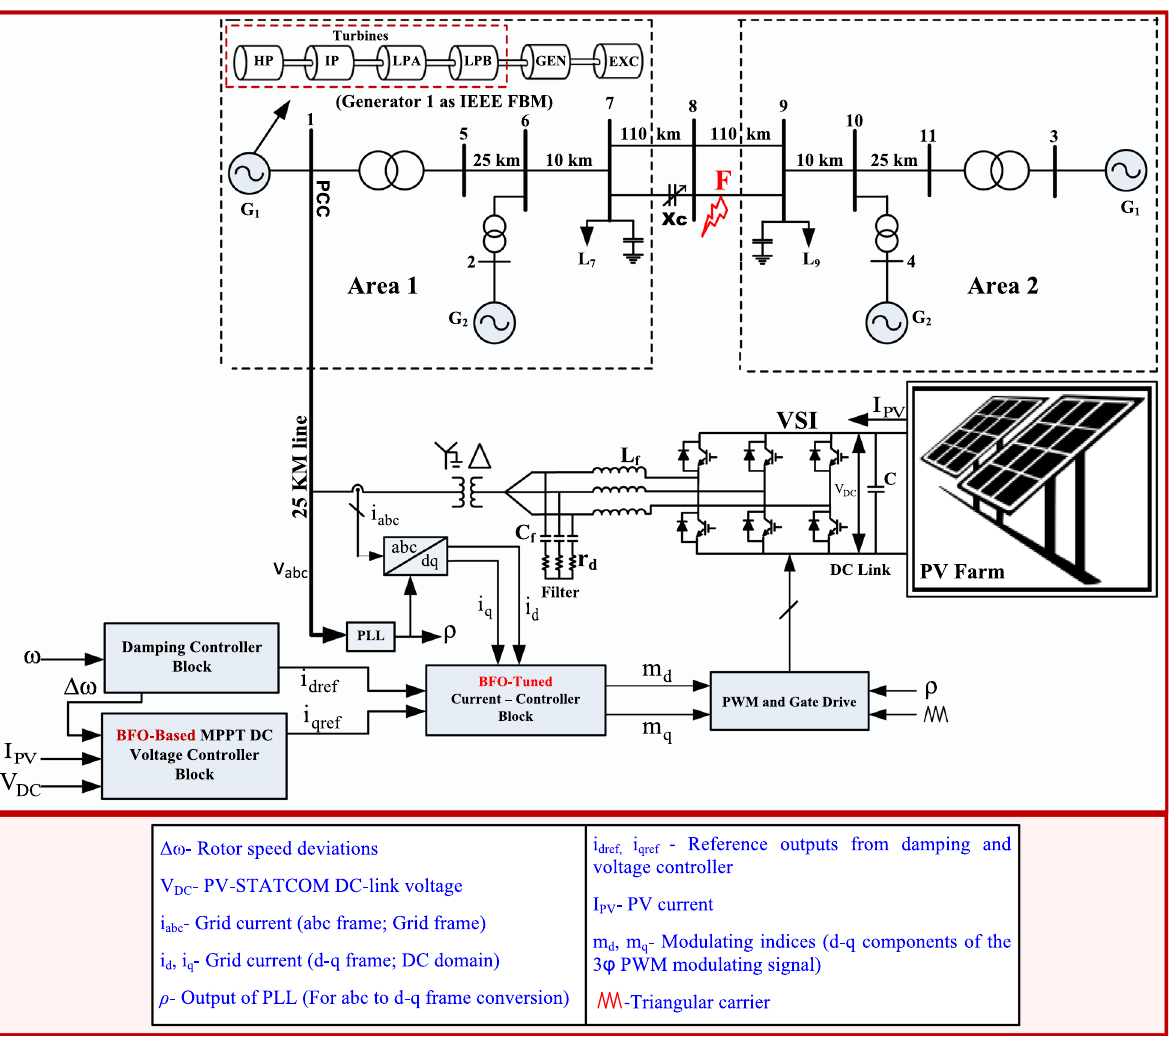
Fig. 2 a Kundur’s multi-machine model aggregated with PV-farm, b the proposed control